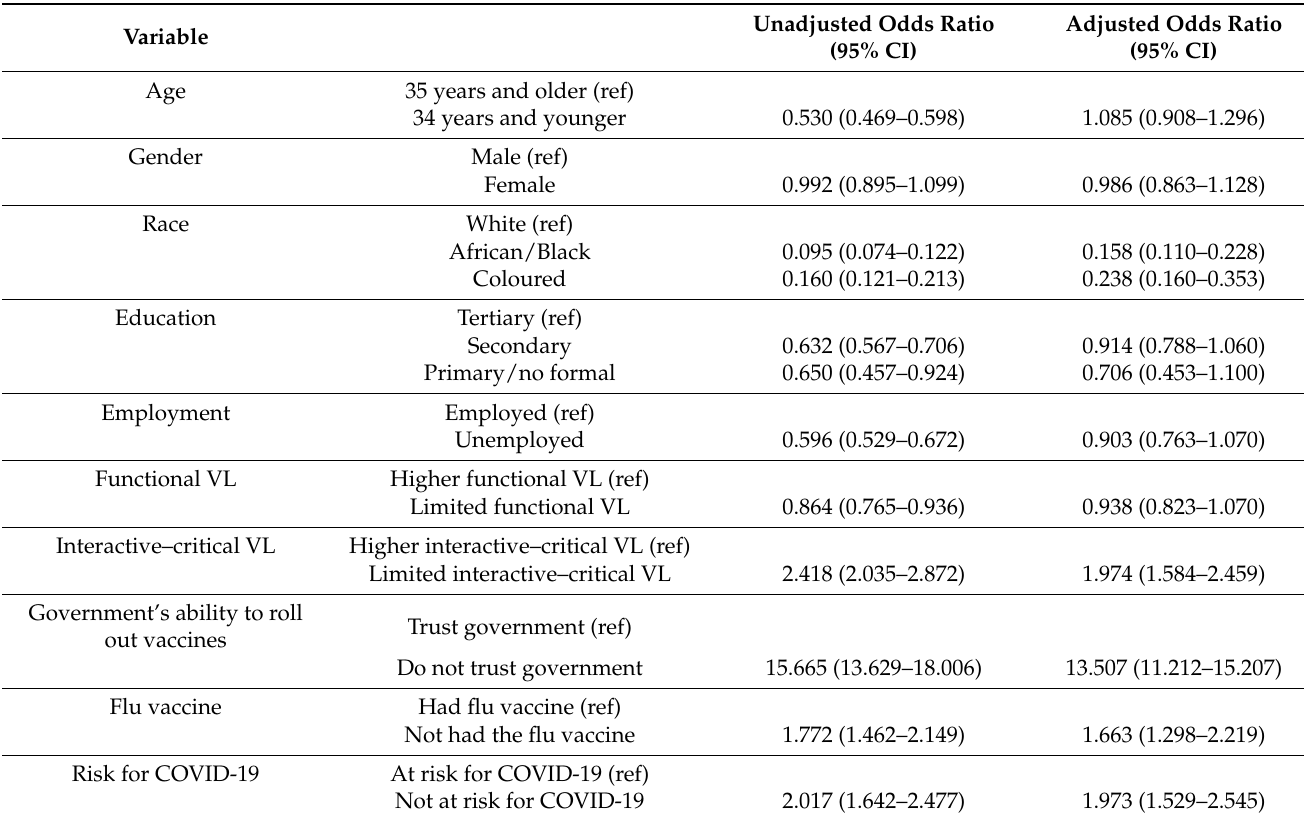
Table 5. Factors associated with COVID-19 vaccine